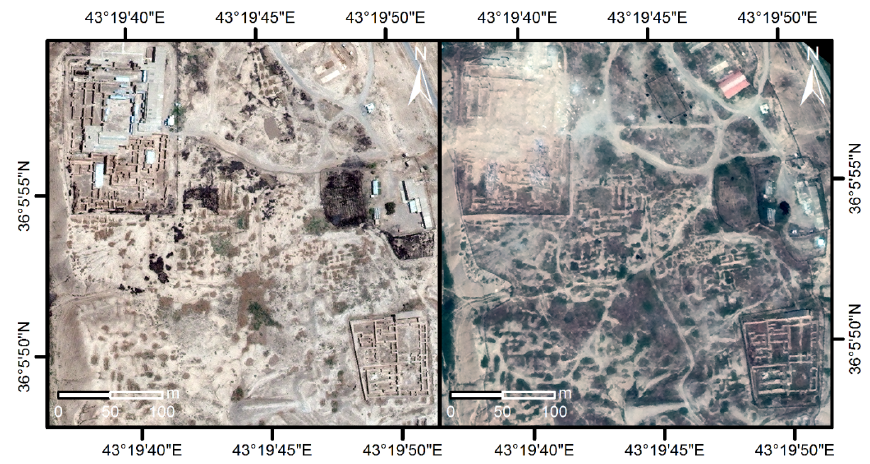
Figure 14. ( left ) Nimrud pre- (GeoEye-1, 11 July 2011) and ( right ) post-event image (WorldView-2, 20 April 2015) ( c (cid:13) European Space